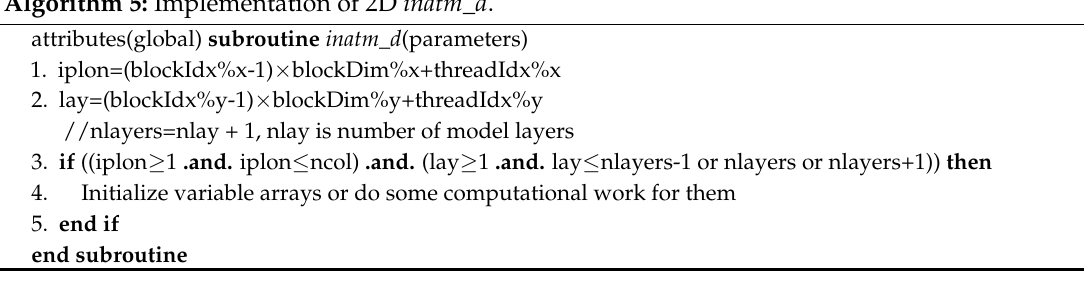
Algorithm 6: Implementation of inatm_d3